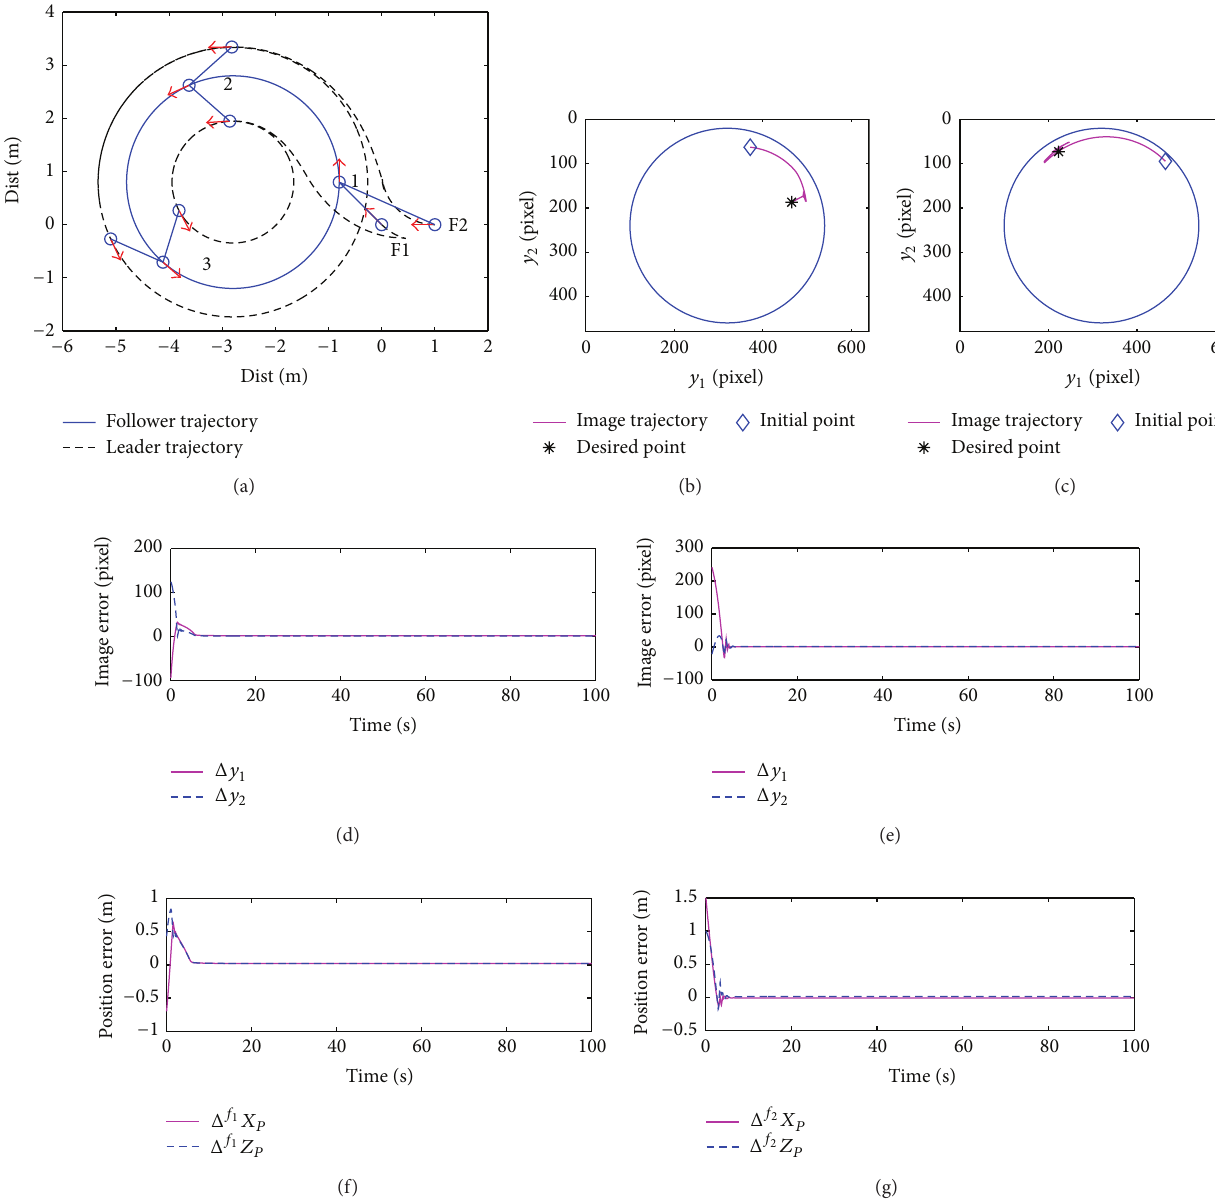
Figure 5: Circle tracking results. (a) Trajectory in world frame. (b) Image trajectory of Follower1. (c) Image trajectory of Follower2. (d) Image error of Follower1. (e) Image error of Follower2. (f) Position error in frame Follower1. (g) Position error in frame Follower2.